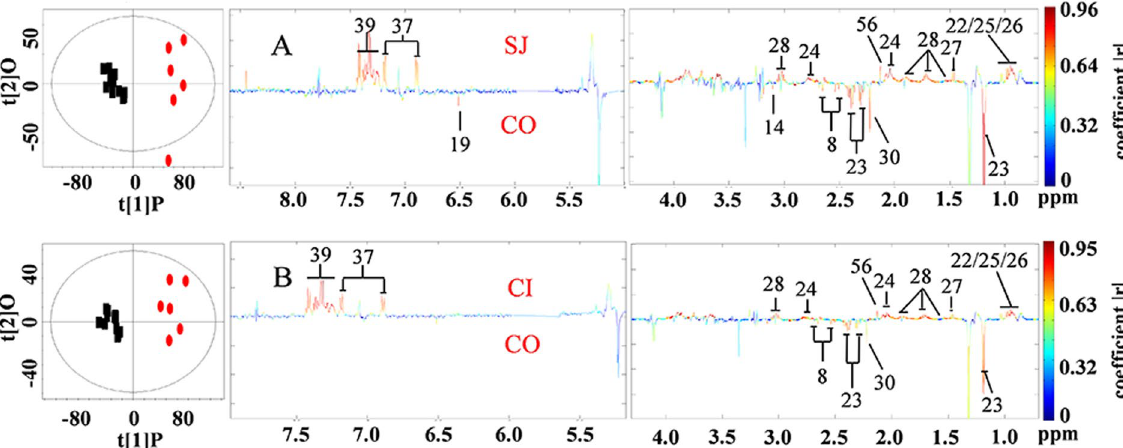
Figure 5. Scores plots and corresponding color-coded coefficient plots. These plots derived from O-PLS-DA of 1 H NMR spectra obtained from serum of uninfected control mice (CO), S. japonicum infected mice (SJ), S. japonicum and S. typhimurium coinfected mice (CI). Signals upwards, increase compared with the control; signals downwards, decrease compared with the control. Keys: 8, citrate; 14, malonate; 19, fumarate; 22, valine; 23, 3-hydroxybutyrate; 24, lipids; 25, isoleucine; 26, leucine; 27, alanine; 28, lysine; 30, acetone; 37, tyrosine; 39, phenylalanine; 56,